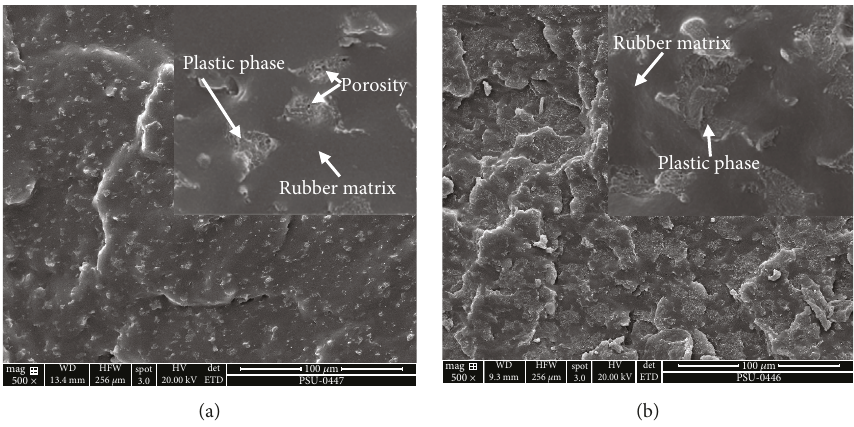
Figure 3: SEM images of TPNR blending with NR/HDPE ratios of (a) R60/P40 and (b)